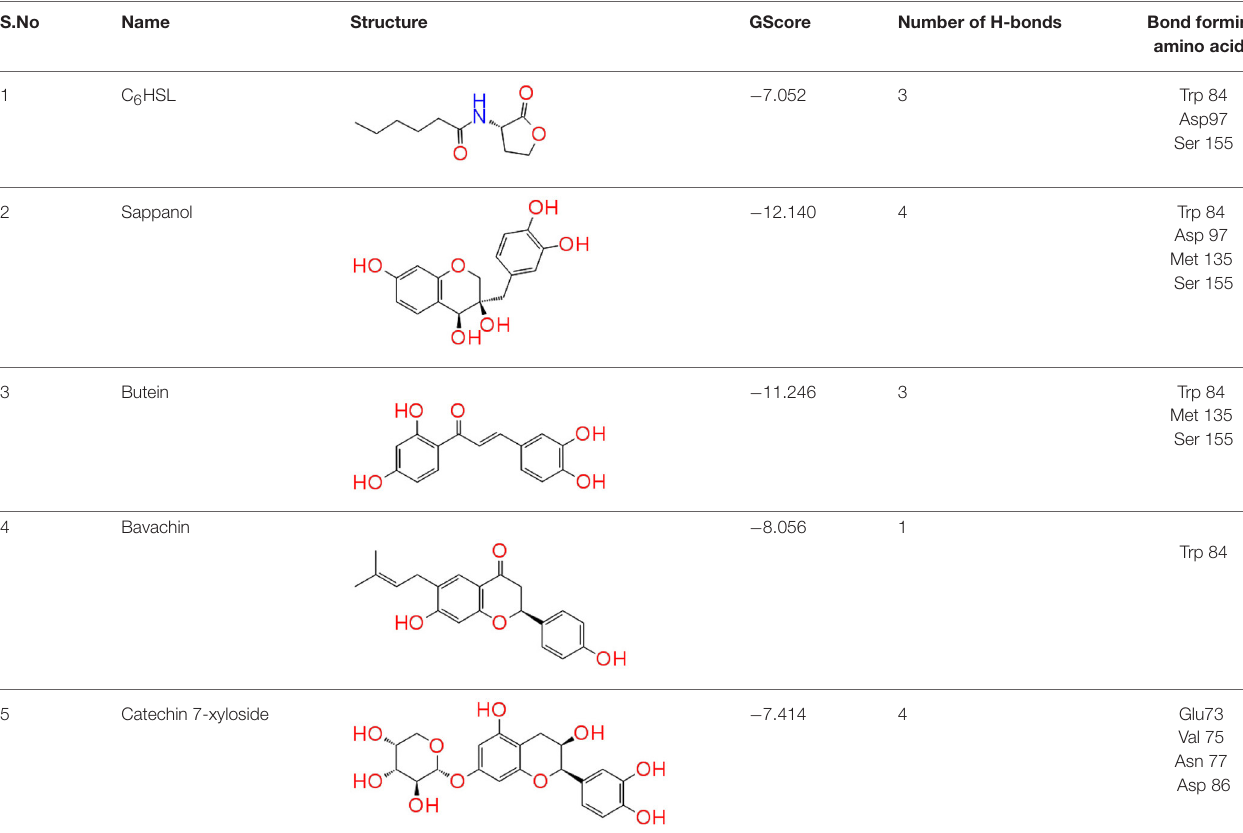
TABLE 1 | Docking analysis of Quorum sensing inhibitors against CivR, the quorum regulator of Chromobacterium violaceum .